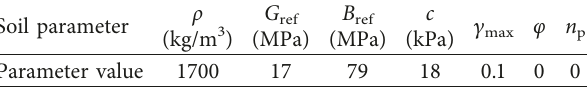
Table 1: Model parameters of soft